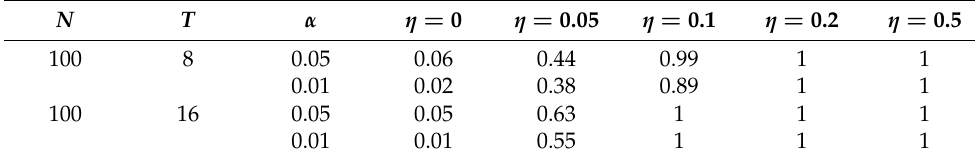
Table 7. Powers of test with significance level α